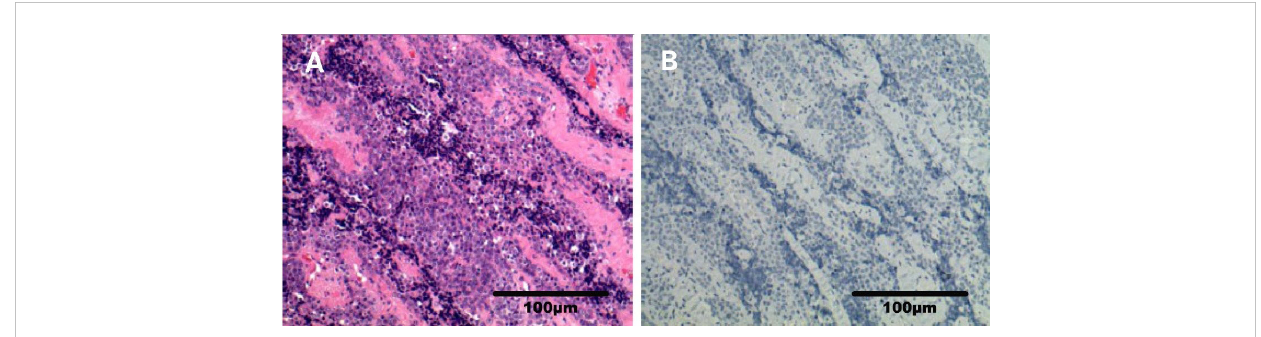
FIGURE 3 Photomicrograph of PD-L1 immunohistochemistry (right parotid gland). (A) Sample HE photomicrograph (x200). (B) Sample PD-L1 IHC photomicrograph (x200).